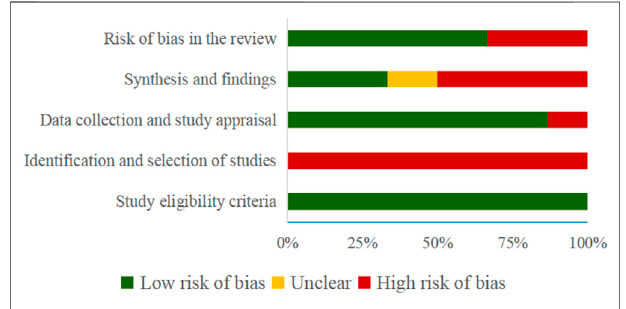
FIGURE 2 | Risk of bias of the included SRs with ROBIS